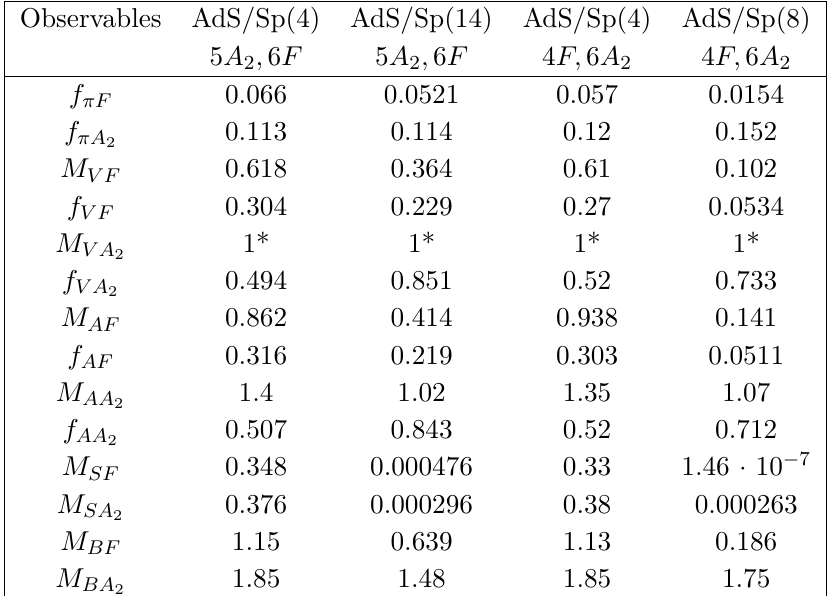
Table 7. Holographic results for masses and decay constants in the Sp(2 N c ) theories with two different matter representations that can trigger chiral symmetry breaking.